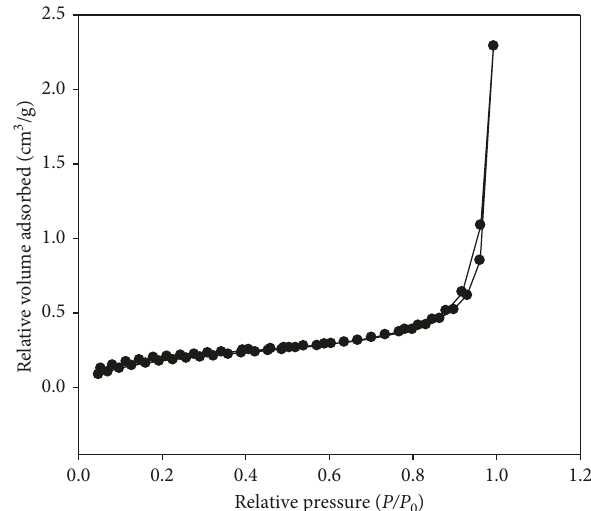
2 adsorption isotherm of wasted tea powder used in this